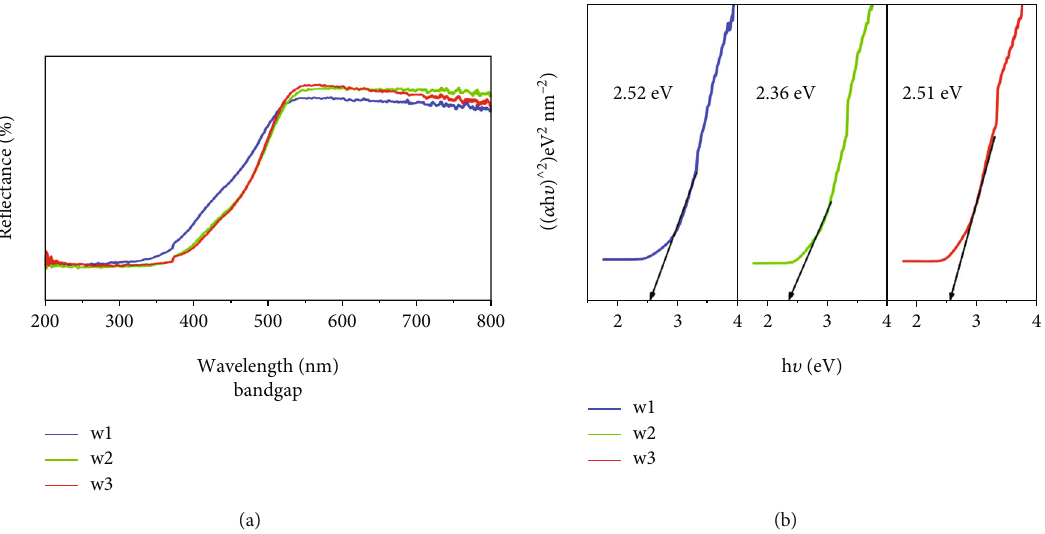
Figure 5: (a) Re fl ectance spectrum. (b) Tauc plot of WO